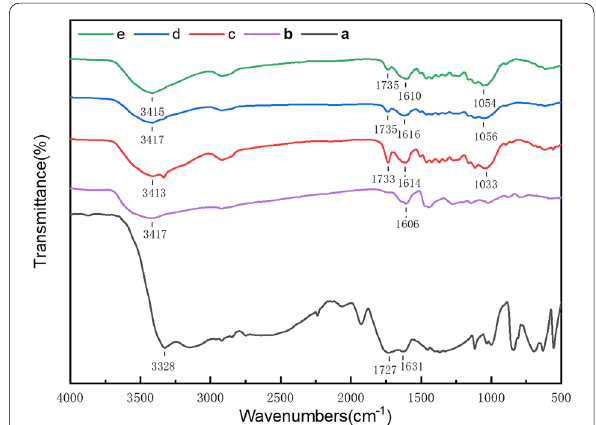
Fig. 11 Fourier transform infrared (FTIR) spectra of raw materials and particleboard powder: a AC foaming agent; b PF resin; c particleboard with 1.0% AC foaming agent; d particleboard with 1.2% AC foaming agent; e particleboard with 1.4% AC foaming